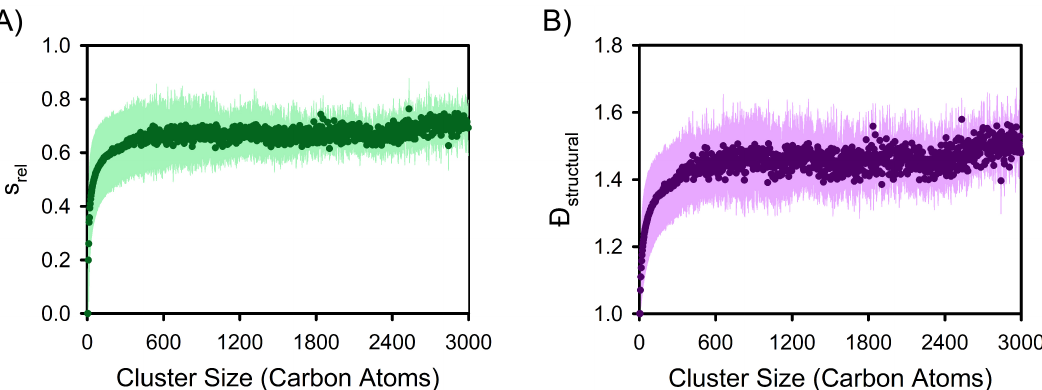
Figure 4. Relative variation in stem length distributions. ( A ) Relative standard deviation in stem lengths (i.e., stem length standard deviation divided by mean stem length) as a function of cluster size. ( B ) Average structural dispersity of nuclei during crystallization; see main text for details and interpretation. In both panels, data points indicate the average values associated with different cluster sizes while the pale-colored areas indicate the corresponding standard